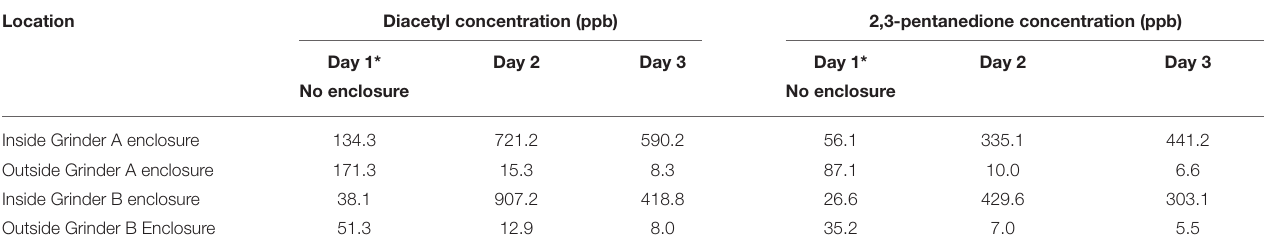
TABLE 2 | Percent change in diacetyl and 2,3-pentanedione concentrations and production volumes across sampling days. Location % Change